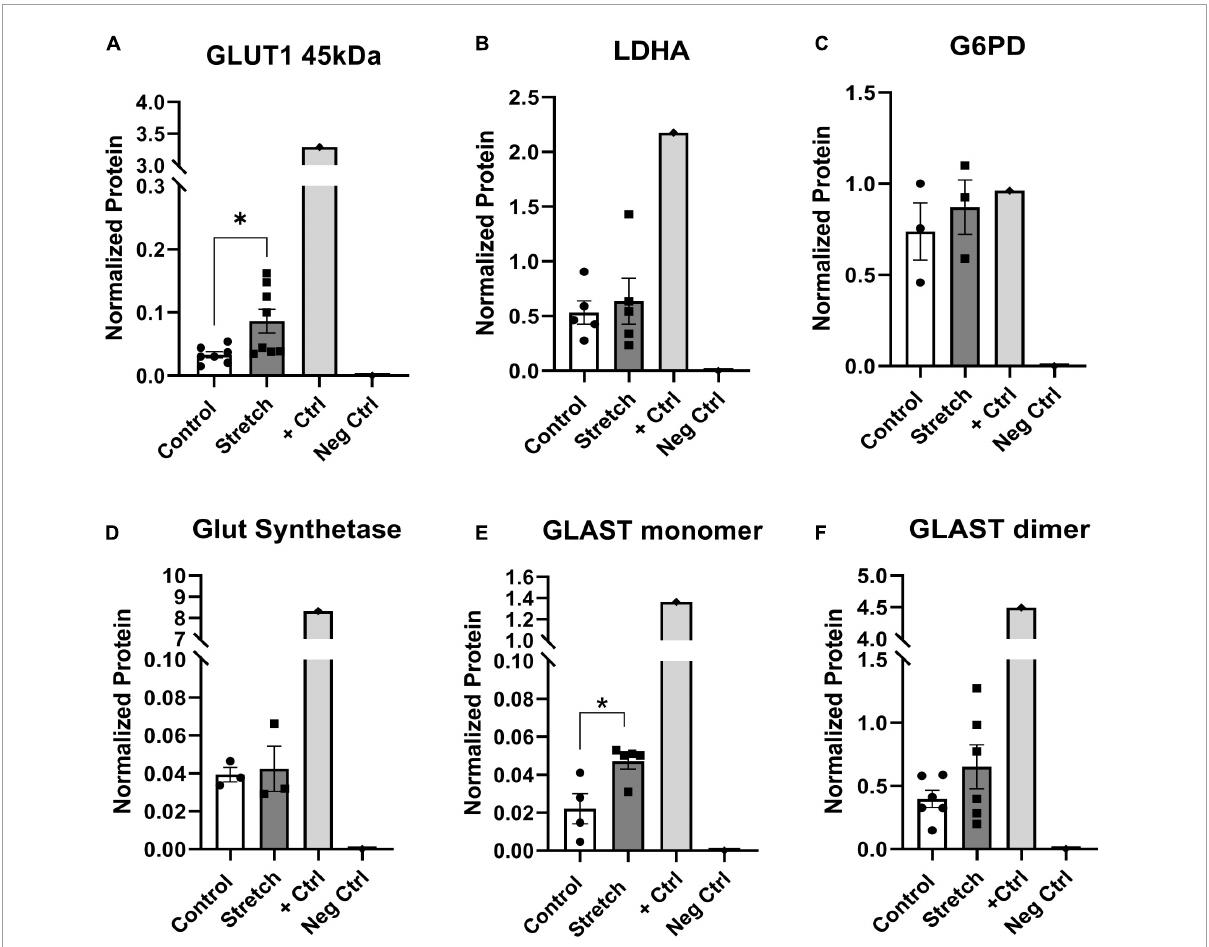
FIGURE5 Protein changes in ONHAs corroborate bioenergetics data . (A) Glucose transporter-1 protein levels in Stretched ONH astrocytes are significantly higher than Control (* p = 0.0225, n = 7 Control, n = 8 Stretch). Retinal lysate from a 2 month-old mouse was used as a positive control for each protein analyzed, while negative control was the signal obtained when no primary antibody was included in the capillary. (B) Lactate dehydrogenase-A, the astrocyte-specific isoform of the enzyme that catalyzes the interconversion of pyruvate and lactate, has equivalent protein levels in Control and Stretch ONH astrocytes. (C) Glucose-6-phosphate dehydrogenase, the enzyme that shunts glucose into the pentose phosphate pathway, is no different in Control and Stretch ONH astrocytes. (D) Glutamine synthetase, the enzyme that synthesizes glutamine from glutamate, is no different in Control and Stretch ONH astrocytes. (E) The monomeric form of glutamate-aspartate transporter (GLAST) has significantly higher protein levels in the Stretch as compared to the Control ONH astrocytes ( p = 0.020; n = 4 Control, n = 5 Stretch). (F) GLAST dimer protein levels are no different in Control and Stretch ONH